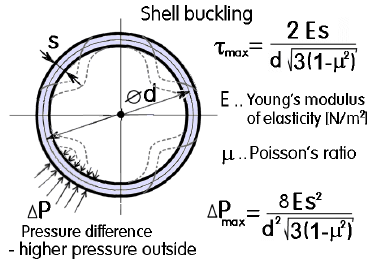
When the melted material decreases its volume due to (as is the case shown in Fig. 6 for the n- eicosane ), the shell may reach at  maxB another limit, the buckling instability.